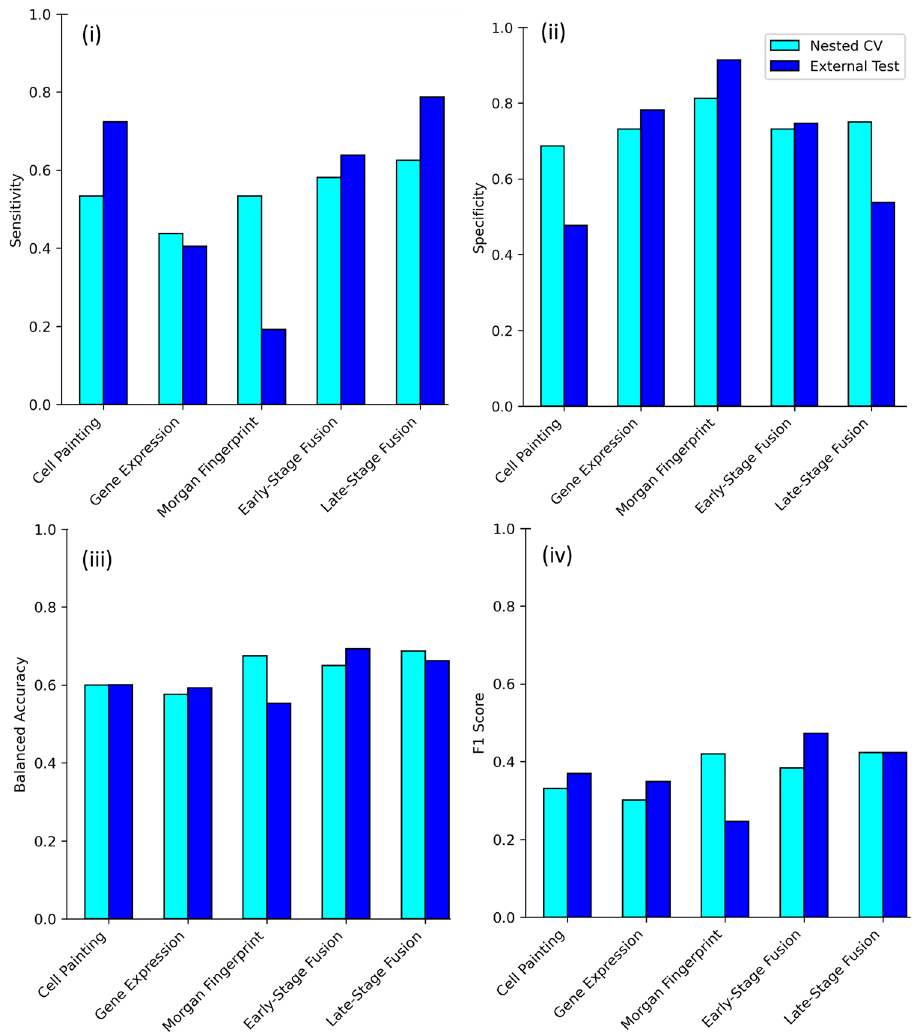
Fig. 8 Performance of models used in this study from nested-cross validations and external validation. Evaluation metrics, namely from (i) sensitivity, (ii) speci fi city, (iii) balanced accuracy and (iv) F1 score for fi ve models from a Nested CV (median of repeated nested cross validations) from the training data ( n = 382 compounds) and b external test set ( n = 244 compounds). Early-stage fusion and Late-stage fusion models combining all three feature sets of Cell Painting, Gene Expression and Morgan have higher F1 score for compounds exhibiting mitochondrial toxicity and extrapolate well into new structural space in external test set compared to models using Morgan fi ngerprints where F1 Score performance falls by 60% (0.25 – 0.40 in absolute